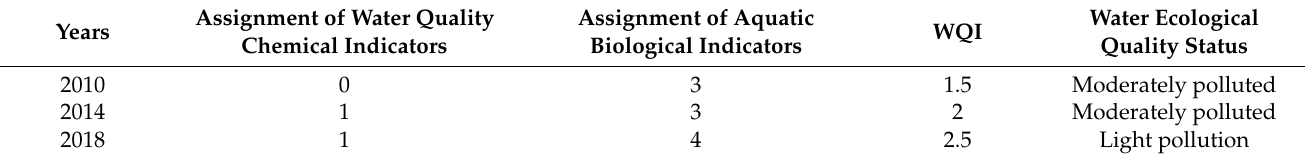
Table 5. Evaluation results of water ecological